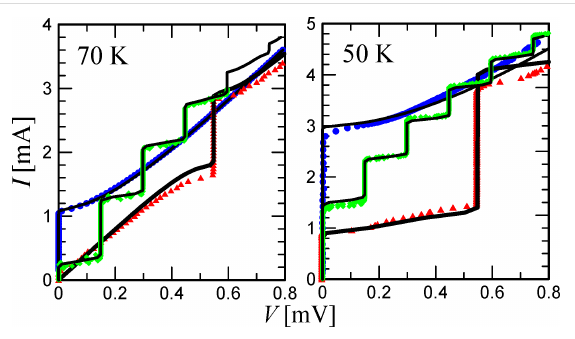
Figure 2: IVCs of a Josephson junction without an MW signal (blue dots), under the action of an external signal of 72 GHz (green diamonds) and 265 GHz (red triangles) at temperatures of 70 and 50 K. The black lines are the numerical calculations for each curve with the experimental parameters and with fitting power P mw